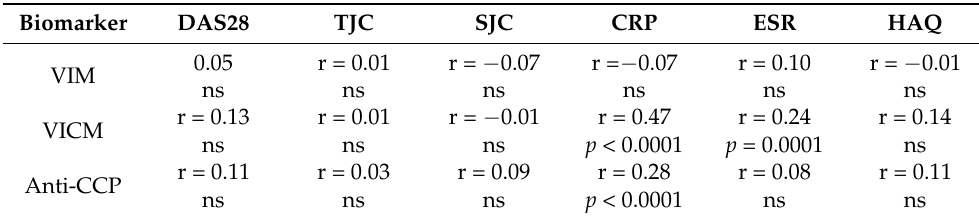
Table 2. Multivariate linear regression between baseline biomarkers and clinical measures of disease activity. Data are shown as a partial correlation (r) adjusted for age, sex, BMI and disease duration. The serological biomarker data were log-transformed. Bonferroni-adjusted alpha < 0.0083. ns, non-significant ( p >